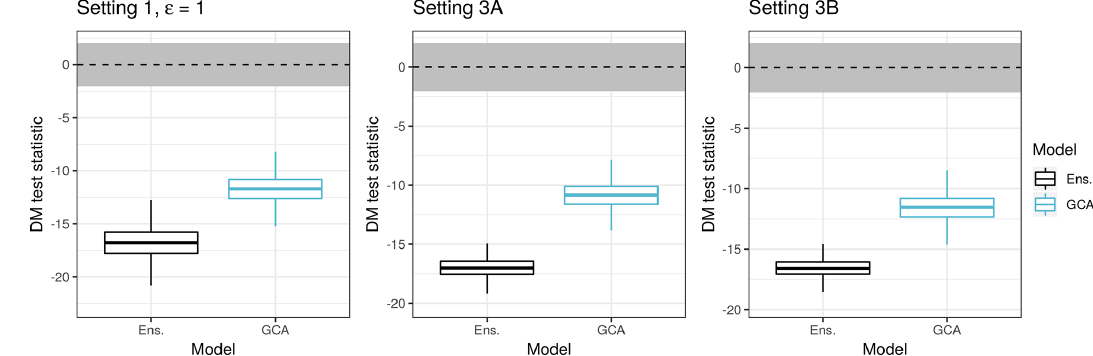
Figure 1. Summaries of DM test statistic values based on the CRPS. ECC-Q forecasts are used as a reference model such that positive values of the test statistic indicate improvements over ECC-Q and negative values indicate deterioration of forecast skill. Boxplots summarize results from multiple parameter combinations for the simulation settings, with potential restrictions on the simulation parameters indicated in the plot title. For example, boxplots in the first panel summarize simulation results from all parameter combinations of Setting 1 (and the 100 Monte Carlo repetitions each) subject to (cid:15) = 1. The horizontal gray stripe indicates the acceptance region of the two-sided DM test under the null hypothesis of equal predictive performance at a level of